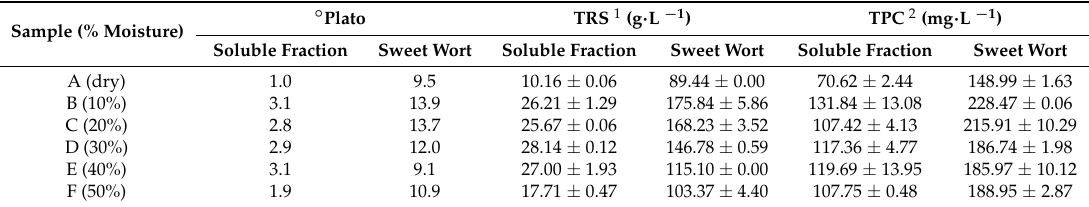
Table 2. Analytical determinations of samples for malted grains with different moisture contents (%) for milling before (soluble fraction) and after mashing (sweet wort).